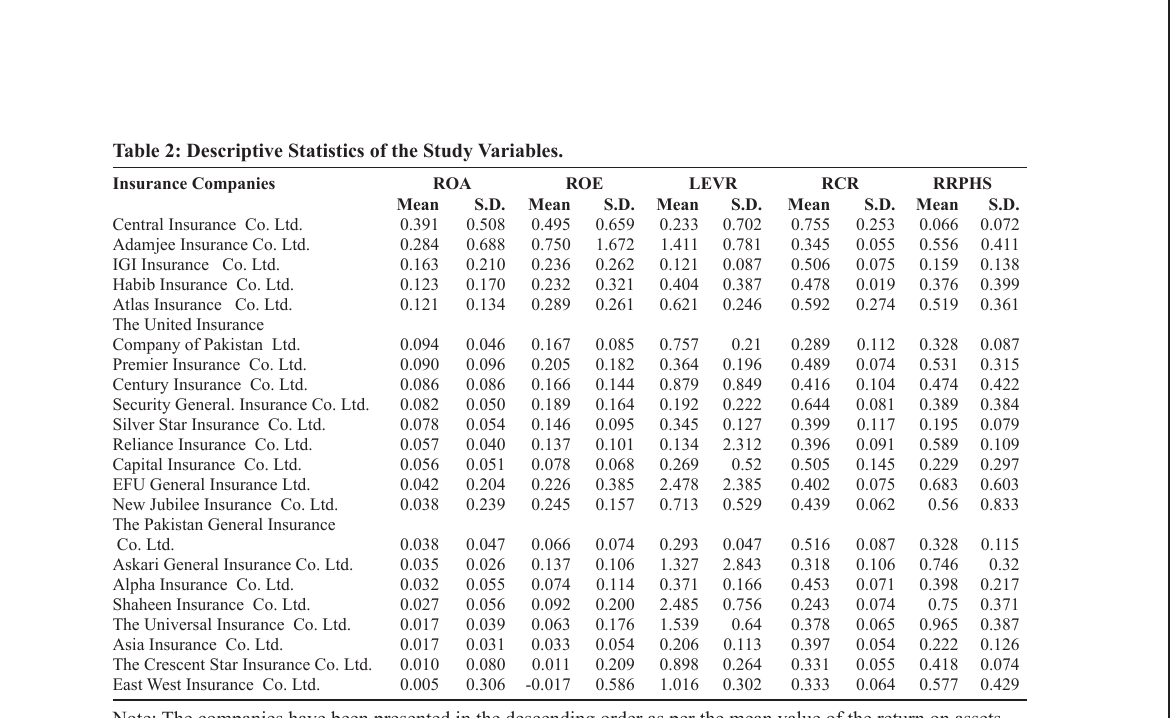
Note: The companies have been presented in the descending order as per the mean value of the return on assets.